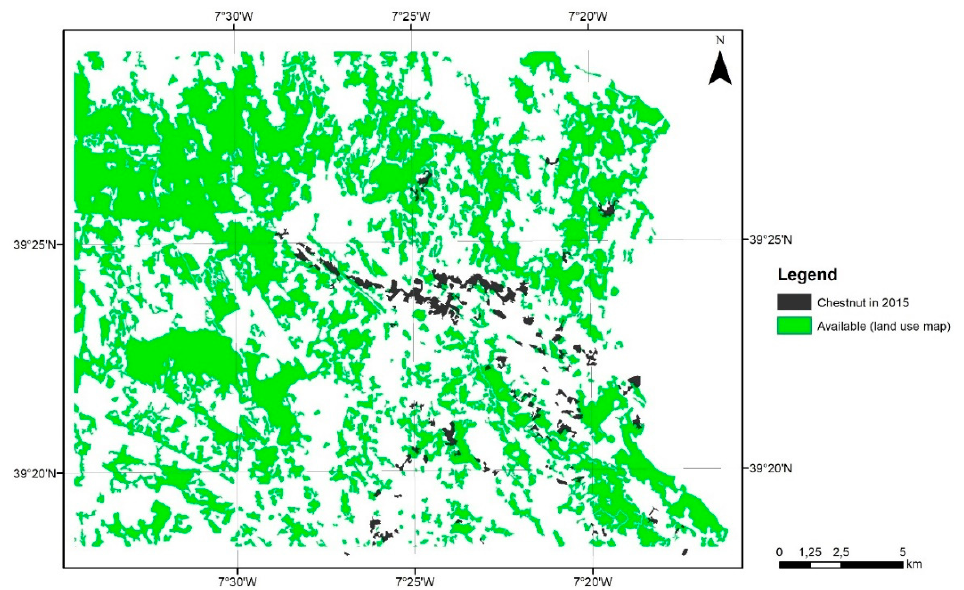
Figure 3. Current and potential expansion areas of chestnut area (right) obtained from filtering the land use/land cover map.